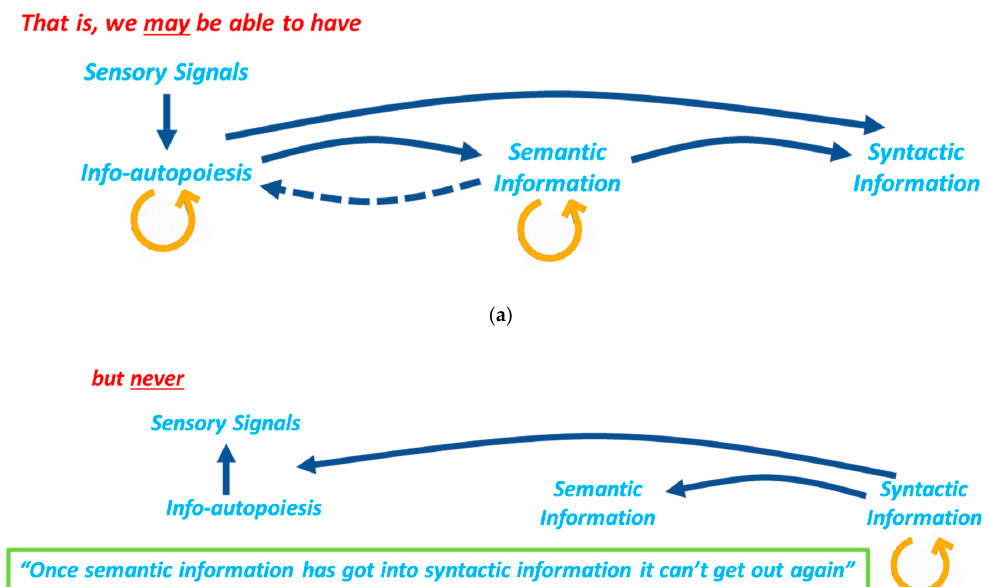
Figure 8. The central dogma of information: ( a ) The possible in the flow of information; ( b ) The impossible in the flow of information.